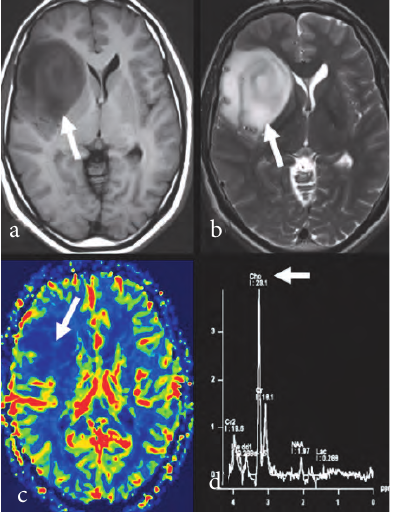
Fig. 3. A 30-year-old man with low-grade astrocytoma. (a - d) Axial T1WI, axial T2WI, CBV map and MR spectroscopy of a patient with a large tumour in the right frontal lobe (arrows a, b). PWI shows low CBV (arrow, c) and MR of 1.5. Despite a very high choline/NAA ratio of 14.3,